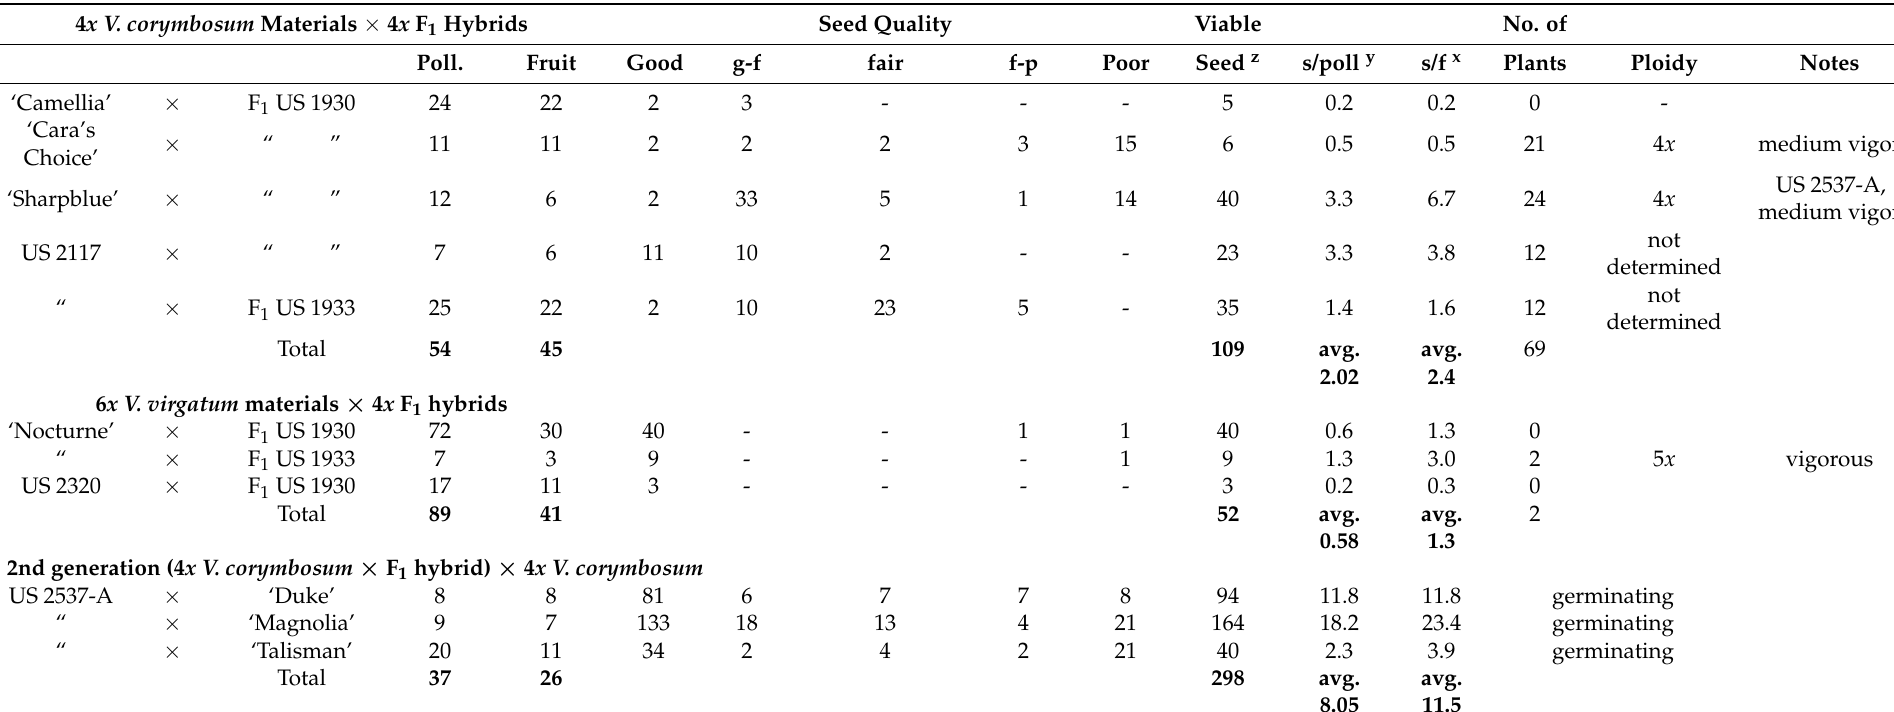
Table 3. Crosses of 4 x V. meridionale — V. vitis-idaea hybrids (US 1930, US 1933) as males with 4 x and 6 x female genotypes and crosses of an advanced generation 4 x hybrid (US 2537-A) with 4 x V. corymbosum